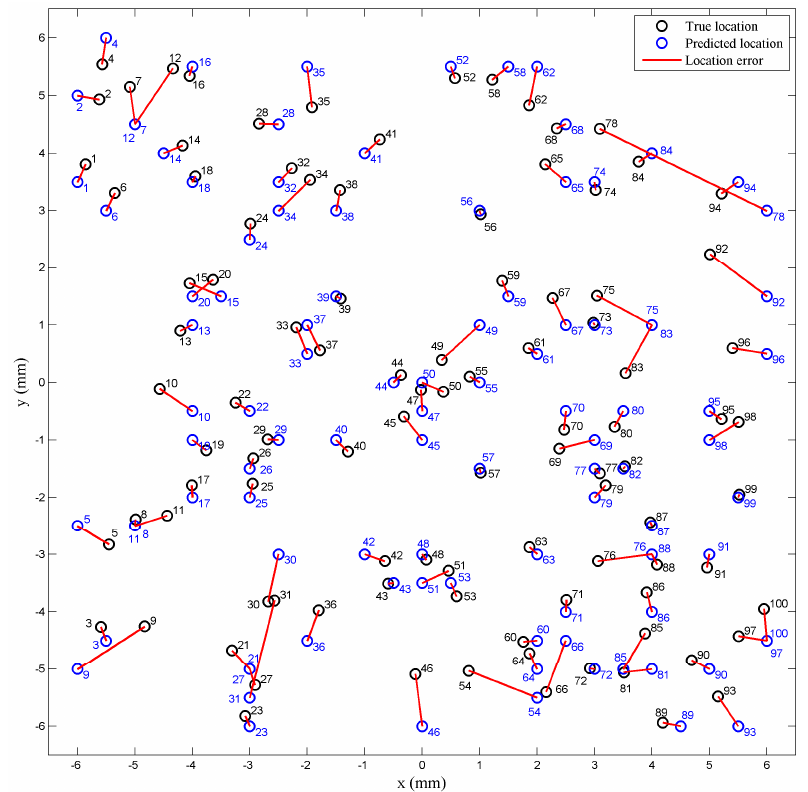
Figure 9. The distribution results of both true locations and predicted locations for 100 random points depicted in a two-dimensional space. Sensors 2018 , 18 , x FOR PEER REVIEW